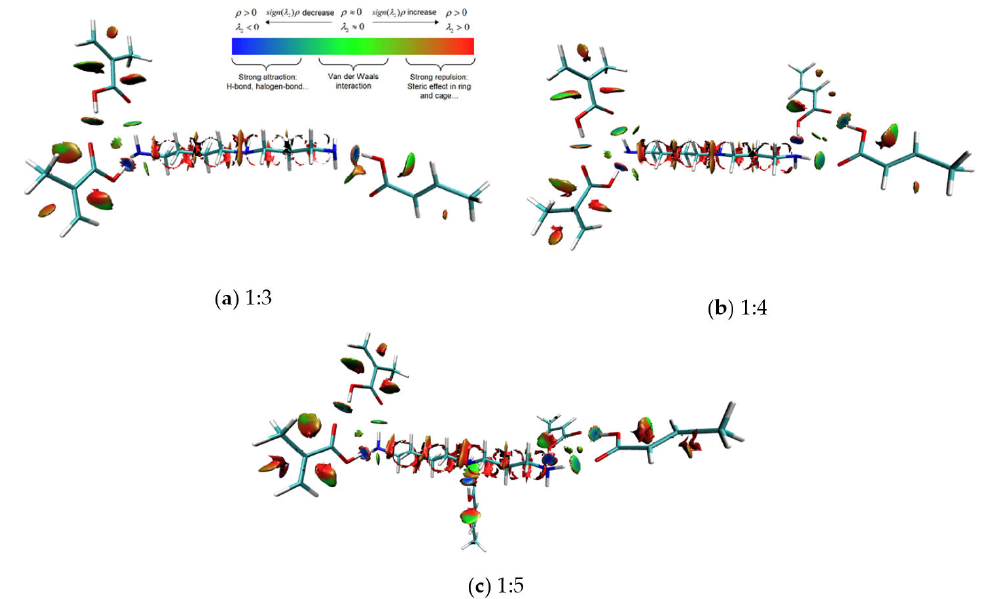
Figure 5. Three-dimensional colored isosurfaces of the three ratios of SPD–MAA complex non-covalent interactions: ( a ) ratio 1:3; ( b ) ratio 1:4; and ( c ) ratio 1:5.